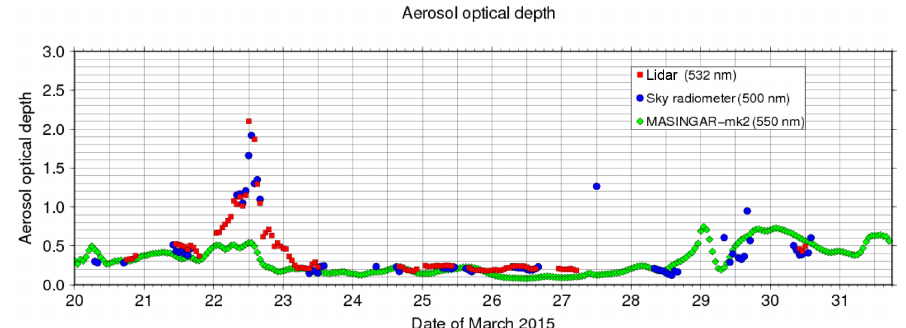
Figure 6. Temporal variation of the aerosol optical depth (AOD) measured by Mie lidar at 532nm (red squares) and by sky radiometer at 500nm (blue circles), and simulated at 550nm by MASINGAR-mk2 (green diamonds).